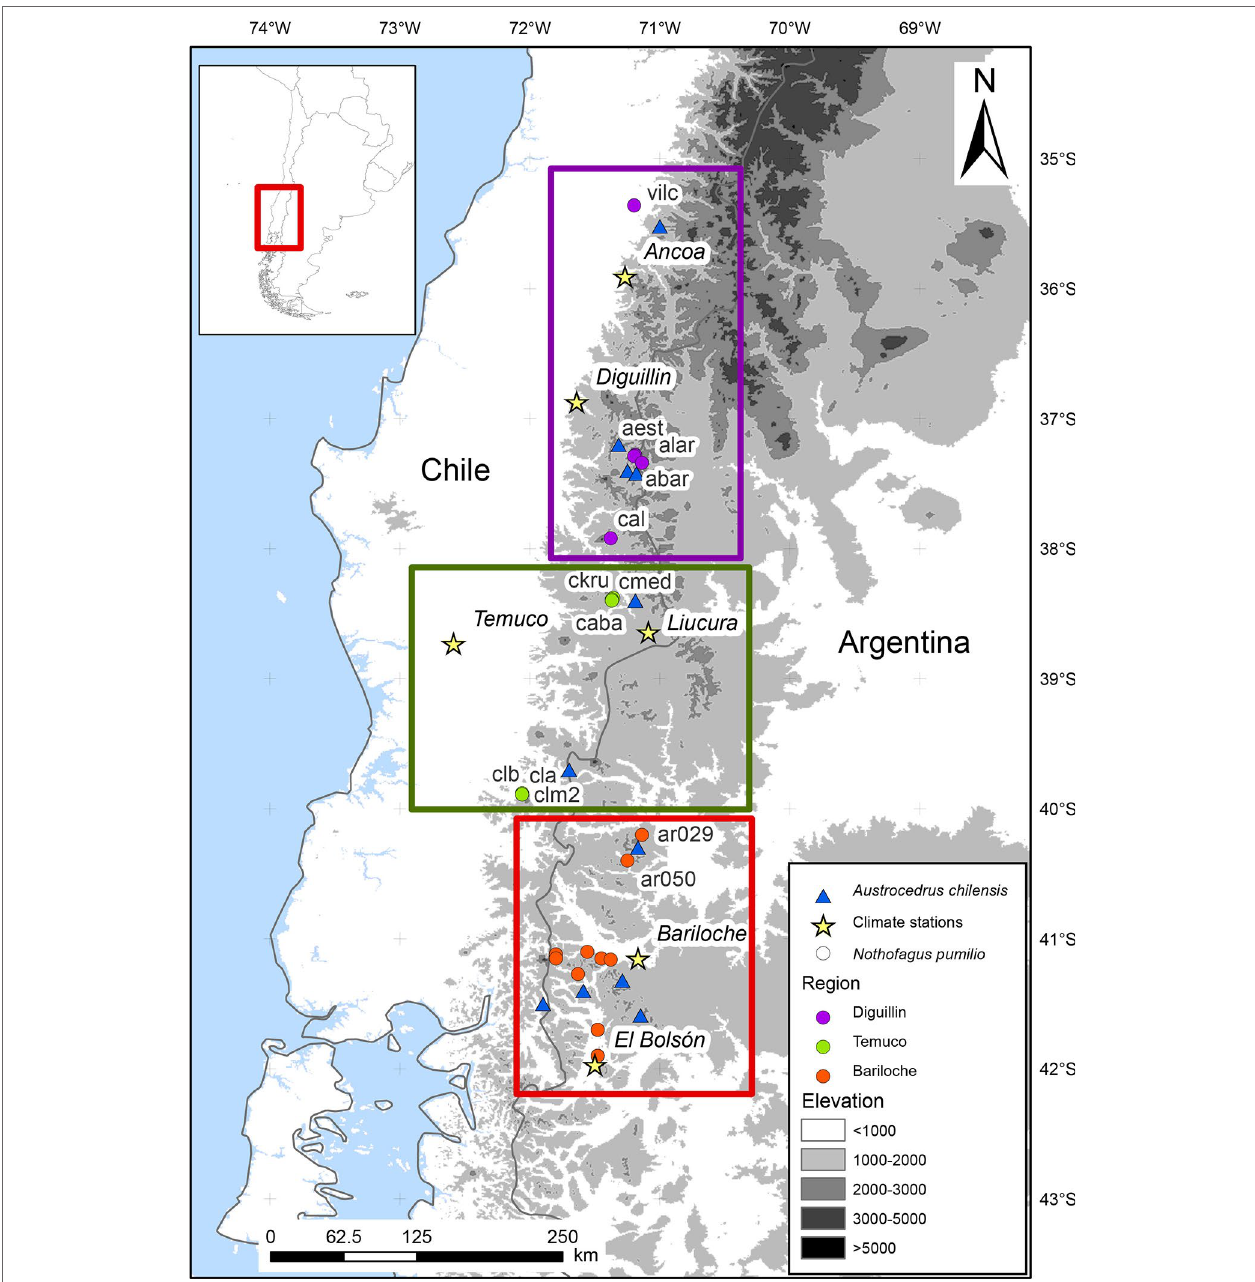
FIGURe 1 | Location of the tree-ring sites and defined regions in the northern Patagonian Andes. Purple, green, and red circles indicate the N. pumilio stands in each region (Diguillin, Temuco, and Bariloche, respectively). Blue triangles indicate the A. chilensi s sites. Yellow stars indicate the two selected meteorological stations of each region. Grey scales illustrate the elevation range. Site codes are shown in Supplementary Table S1